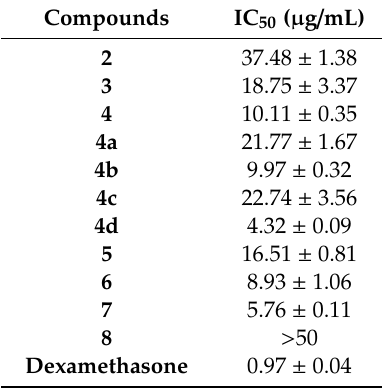
Table 3. Inhibitory e ff ect of compounds 2–8 and 4a – 4d against NO production in LPS-stimulated RAW 264.7